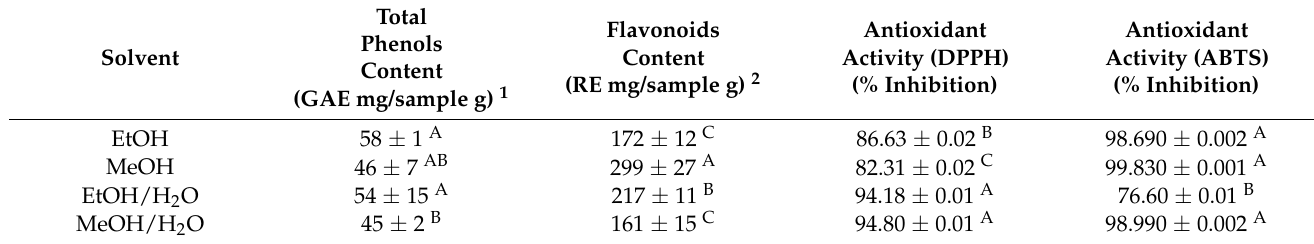
Table 2. Secondary metabolite evaluation in the Eucalyptus globulus L.